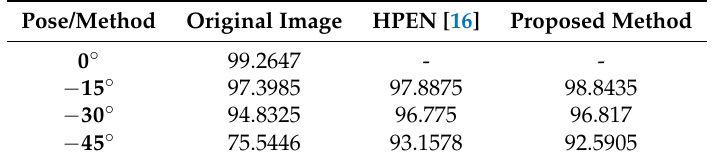
Table 1. Rank-1 recognition rates for Multi-PIE under variations in pose achieved by the proposed frontalization